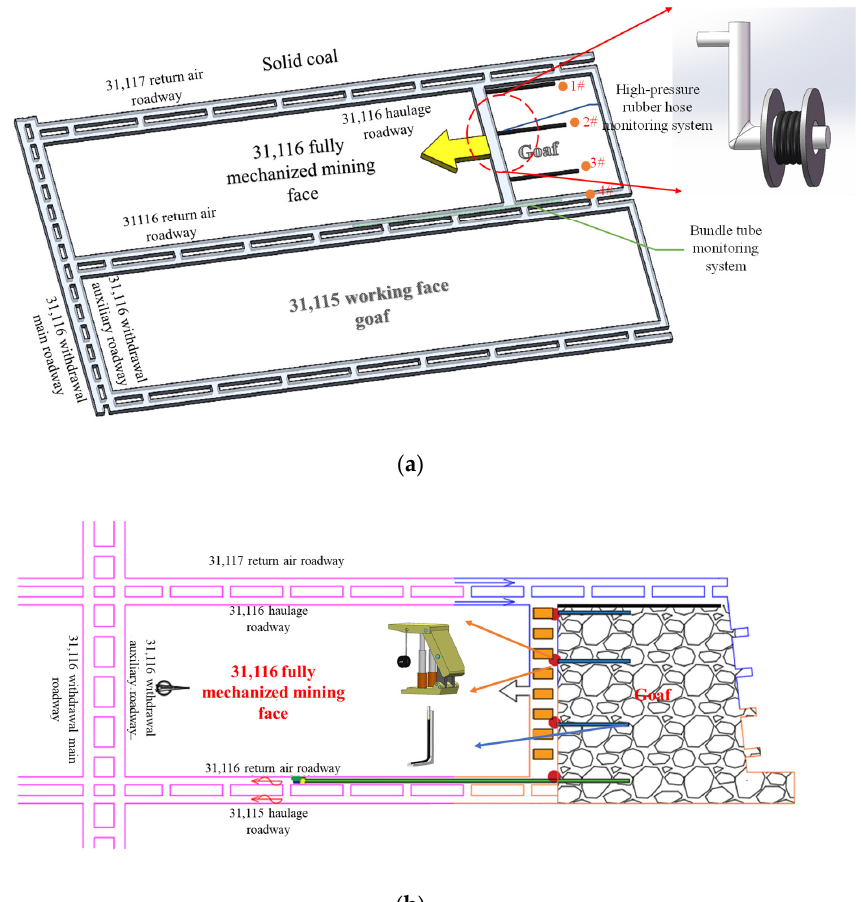
Figure 1. Monitoring pipeline layout in the three zones of gob (own elaboration). ( a ) Roadway layout of 31,116 fully mechanized working face. ( b ) Plan view of the three zones of gob with monitoring pipelines buried.